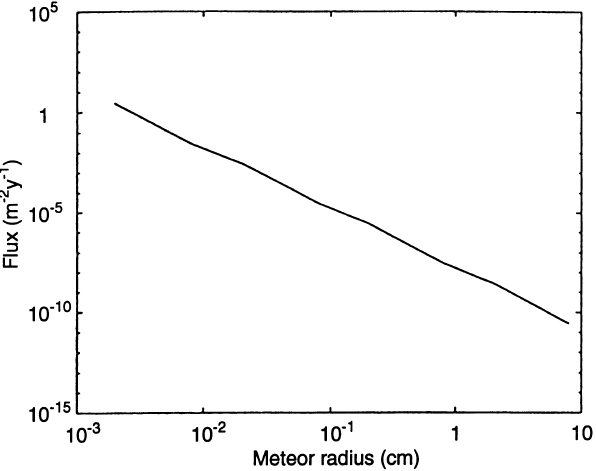
Fig. 11. Meteor flux as function of meteor radius at a height of